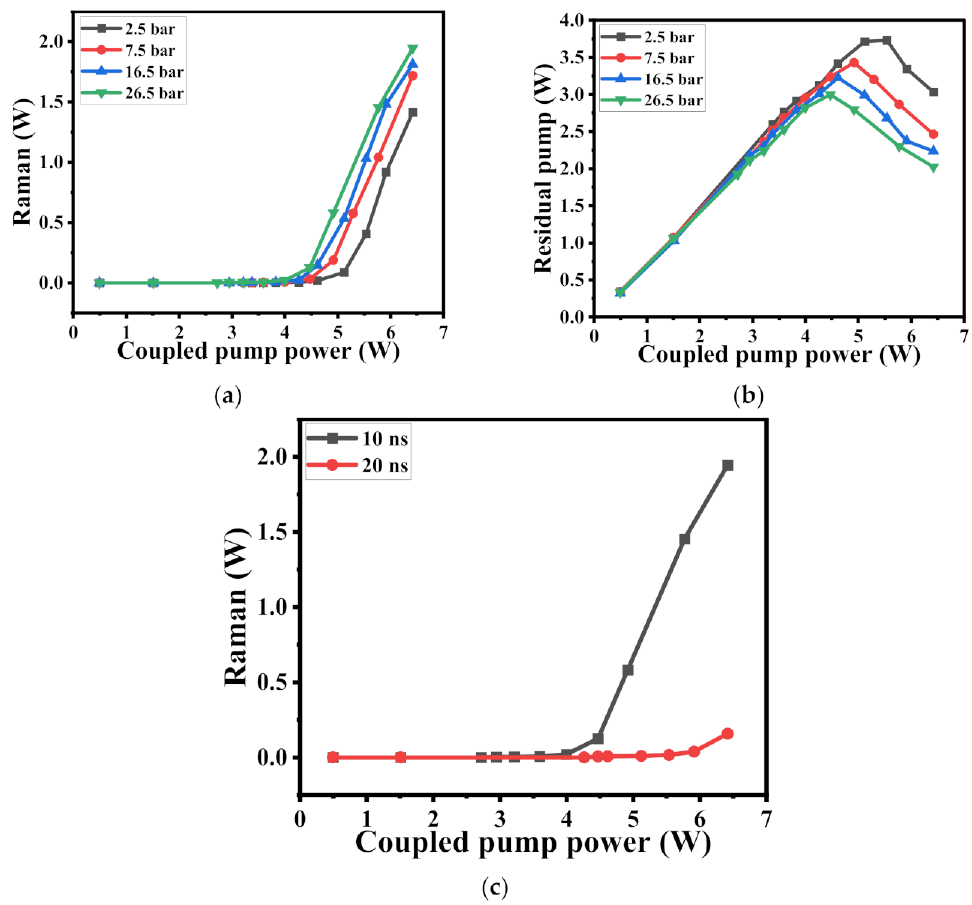
Figure 7. The evolution of ( a ) Raman power and ( b ) residual pump power with respect to the coupled pump power under different deuterium pressures; ( c ) the evolution of Raman power at different pumping pulse width (fiber length of 12.8 m, repetition frequency of 1.5